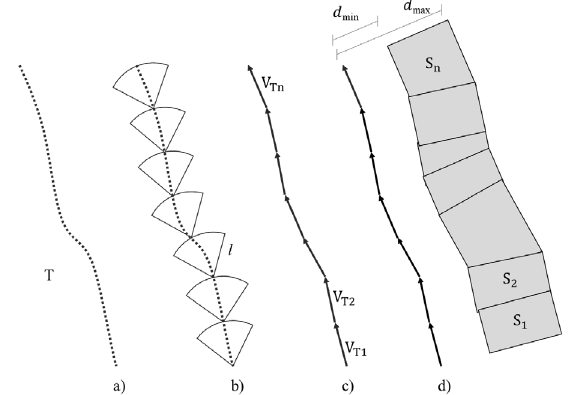
Figure 2. Segmentation from road centreline, top view: a) points belonging to road centreline, b) radius search along trajectory, c) vectorization, d) point cloud in stretches (adapted from Balado et al,